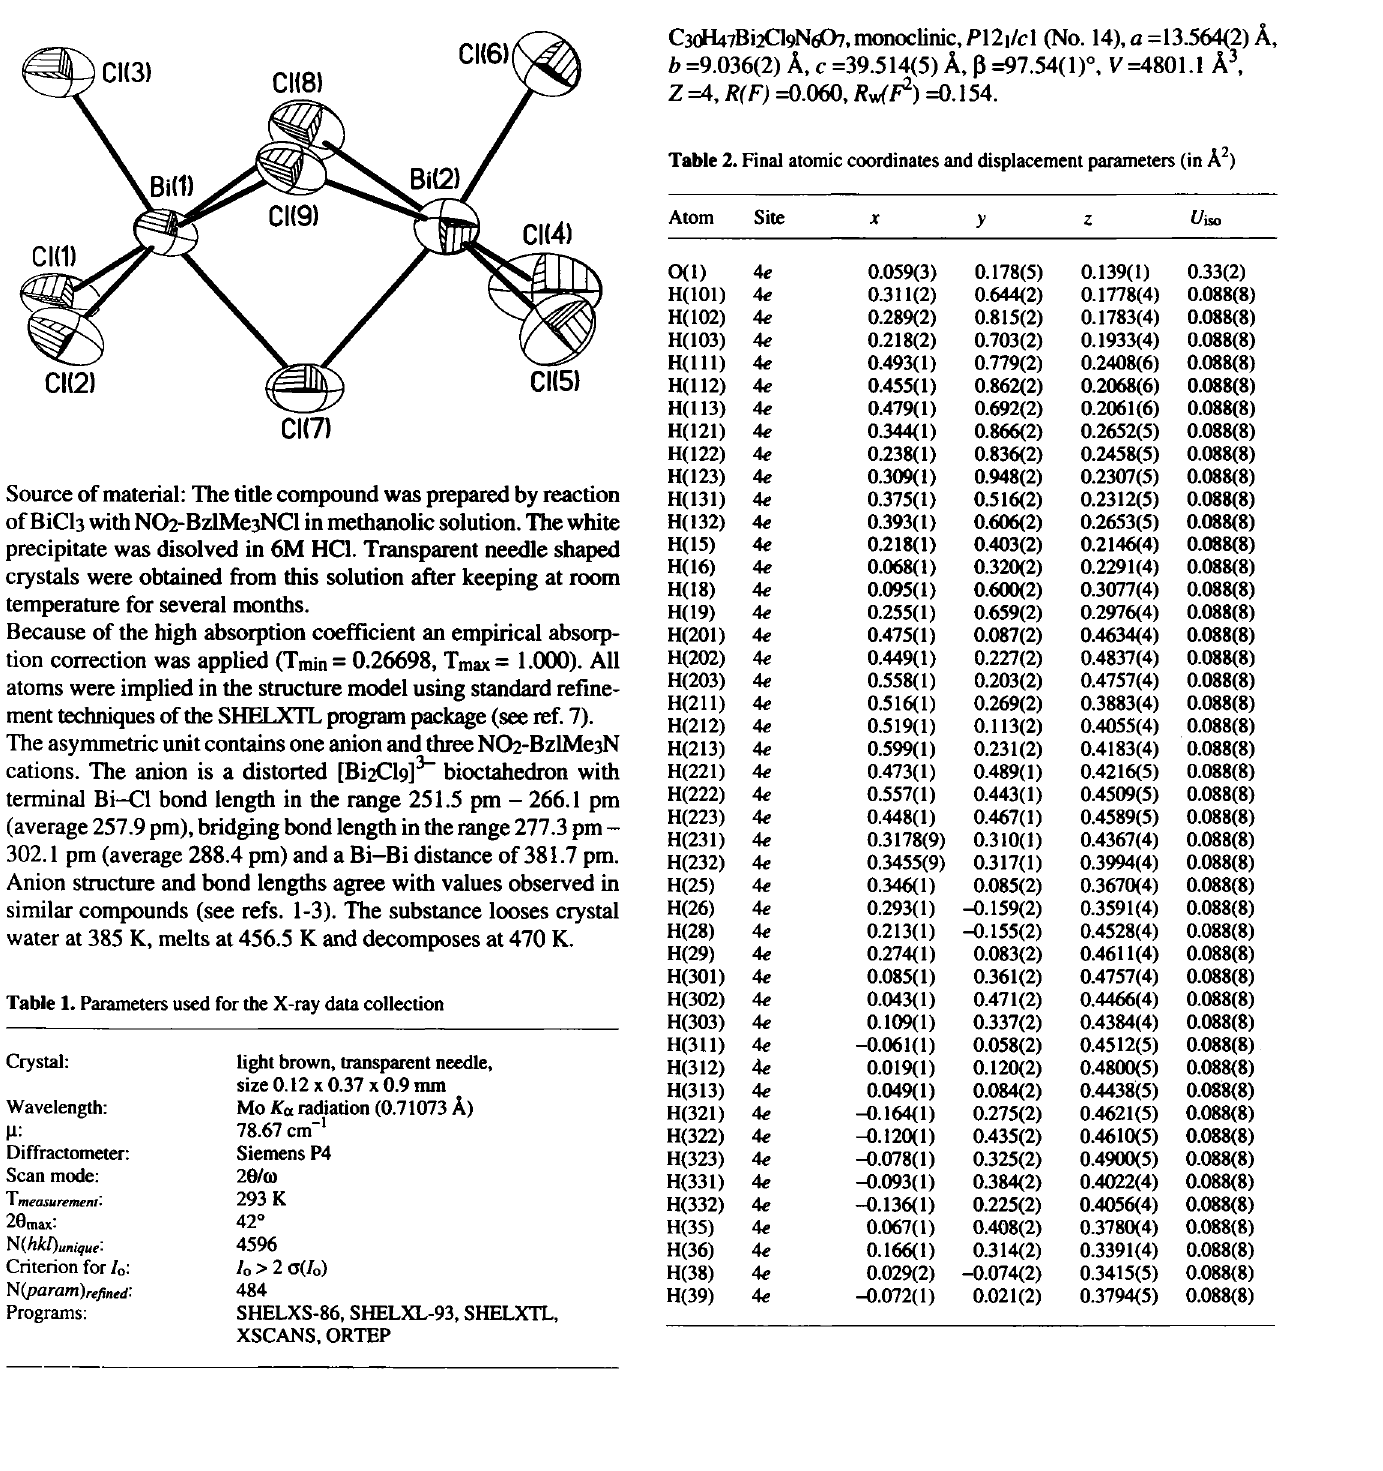
Table 2. Final atomic coordinates and displacement parameters (in